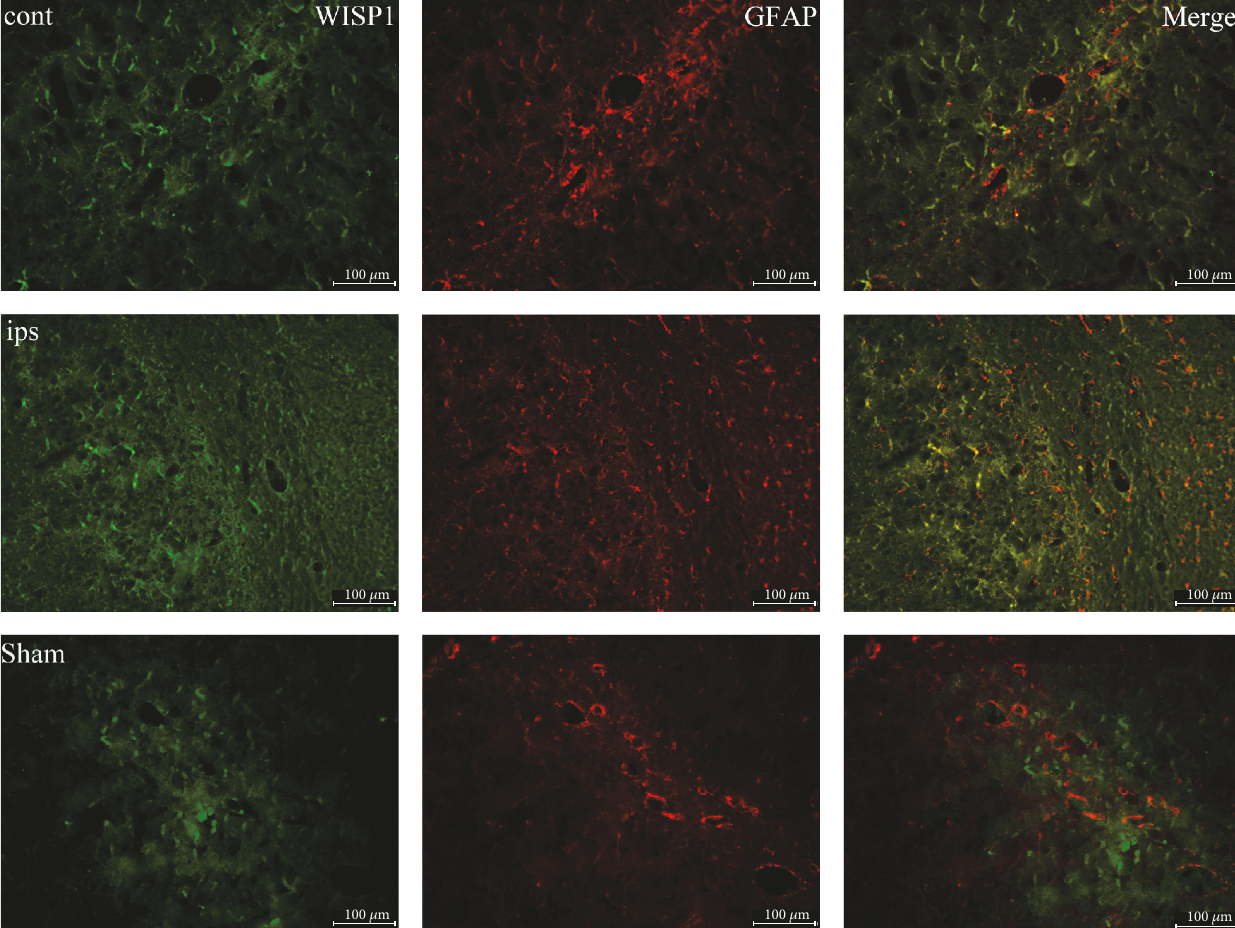
Figure 2: Double-labeling immuno fl uorescence of WISP1 and GFAP at 3d after TBI. Green: WISP1; red: GFAP; cont: the control of ipsilateral 3d post-TBI group; ips: ipsilateral 3d post-TBI group; sham: sham group; bar =100 μ m.